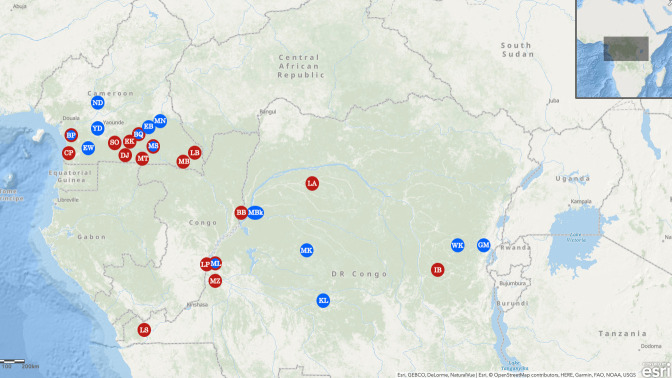
Sample collection sites.Sites where samples from non-human primates (NHPs) were collected are highlighted with circles on the maps, as follows: blue indicates sites where bushmeat samples from monkeys were collected; red, sites where fecal samples from apes were collected; blue and red, sites where bushmeat samples from monkeys and fecal samples from apes were collected. Abbreviations of sites are as follows: BP, Bipindi; BQ, north of Dja; EB, Eboumetoum; EW, Ebolowa; GM, Goma; KL, Kole; MBk, Mbandaka; MK, Monkoto; ML, Malebo; MN, Mindourou; MS, Messok; ND, Nditam; WK, Walikale; YD, Yaoundé.